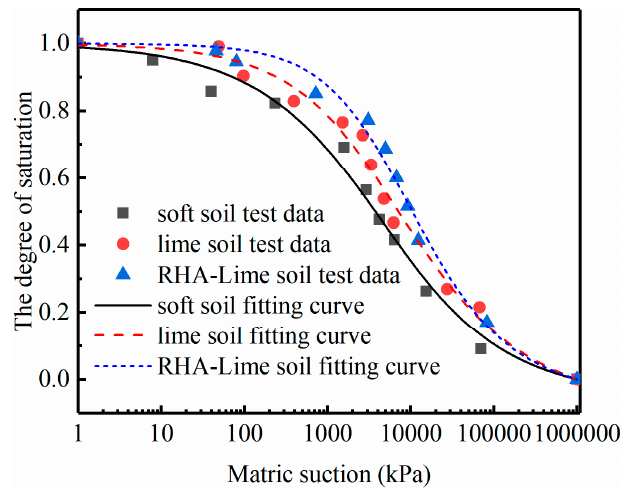
Figure 5. SWCC of the selected three kinds of soils. Table 3. Results of the SWCC model coefficients.